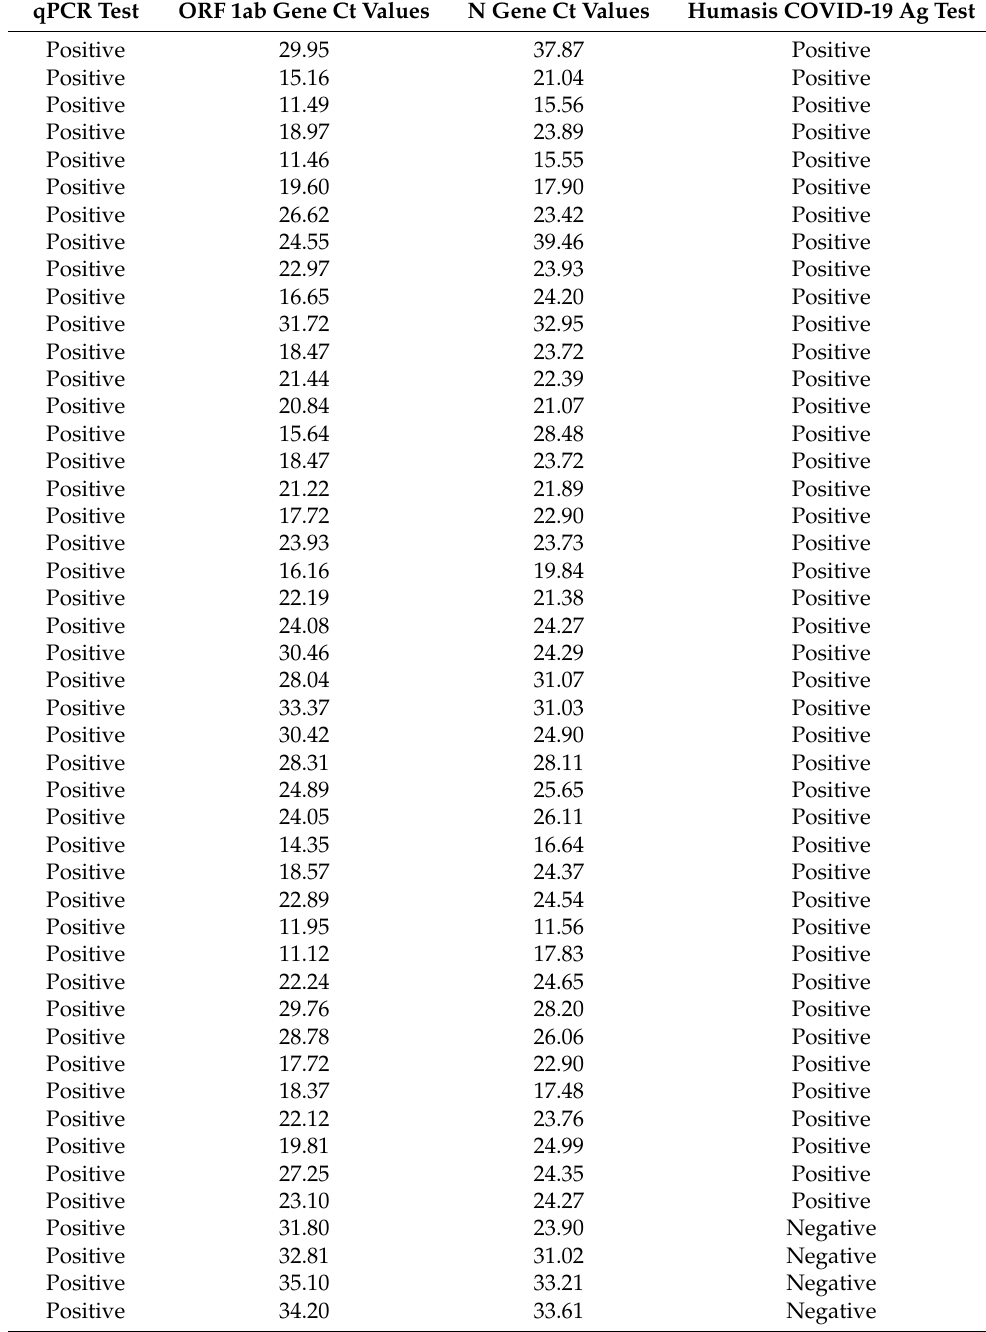
Table 2. Summary of the positive-sample Ct values obtained by the qPCR method and the Humasis COVID-19 Ag